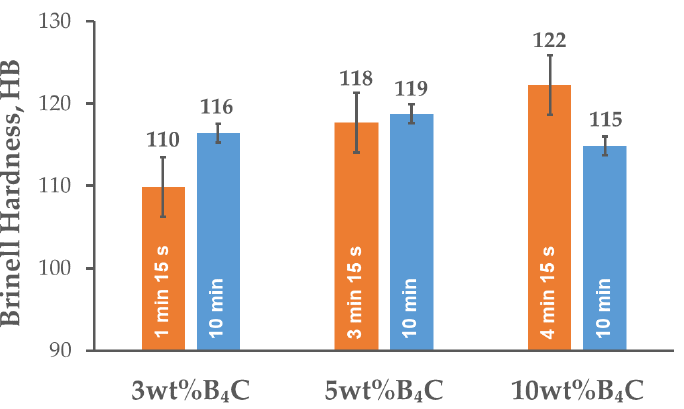
Figure 7. Brinell hardness of AA7075-B 4 C composites spark plasma sintered at various holding